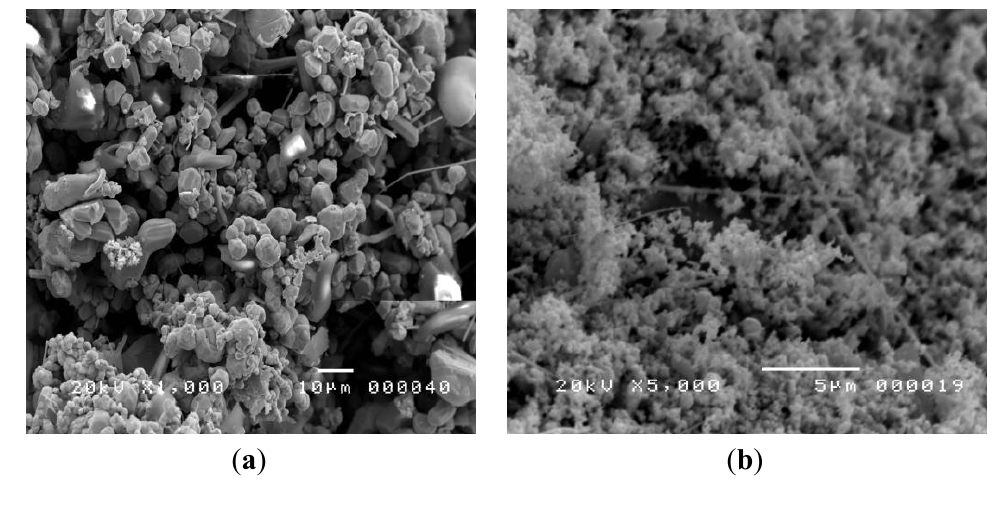
Figure 1. SEM images of nanomaterials ( a ) silver; ( b ) tin oxide; and ( c , d ) silver tin